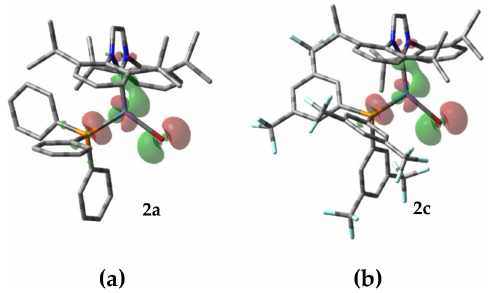
Figure 2. Kohn–Sham orbitals of SOMO corresponding to a density isosurface value of 0.02 au in ( a ) 2a and ( b ) 2c obtained from single-point DFT calculation with B3LYP / 6-31G(d,p) level using the crystallographic